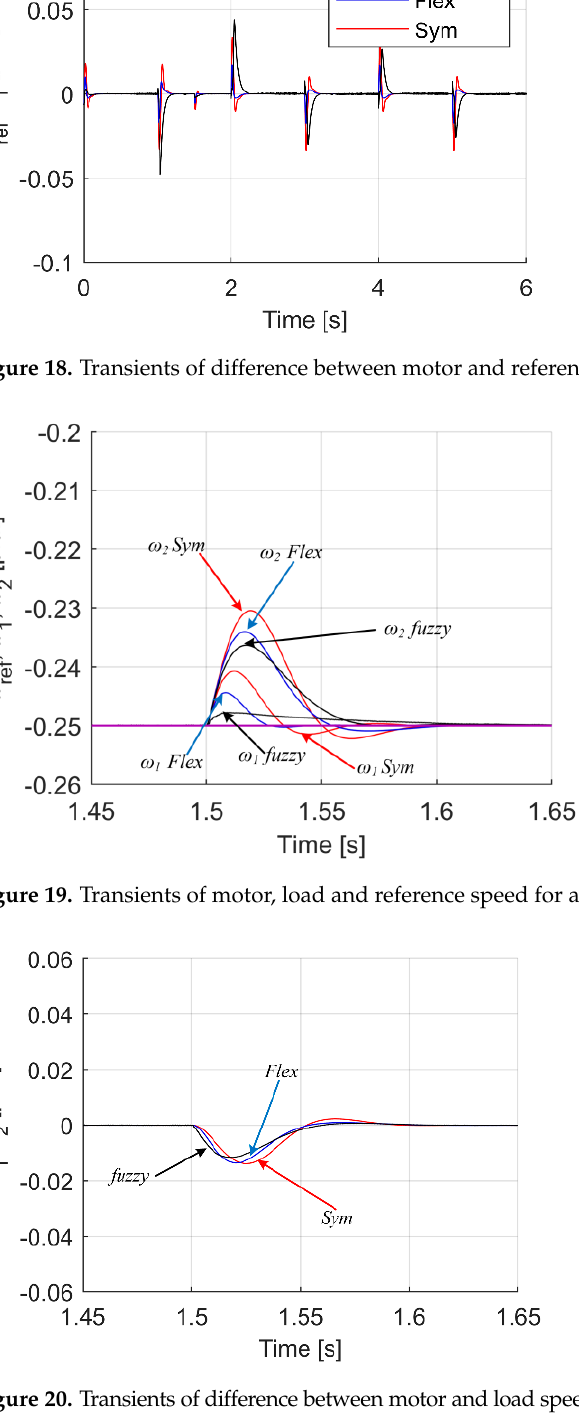
Figure 20. Transients of difference between motor and load speed for analyzed controller cases—zoom.